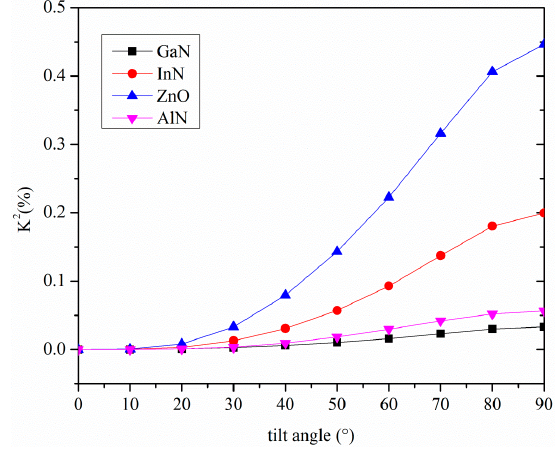
Figure 3. The K 2 of the Love wave travelling along the x propagation direction of AlN, GaN, InN and ZnO substrates vs. the c-axis tilt angle.